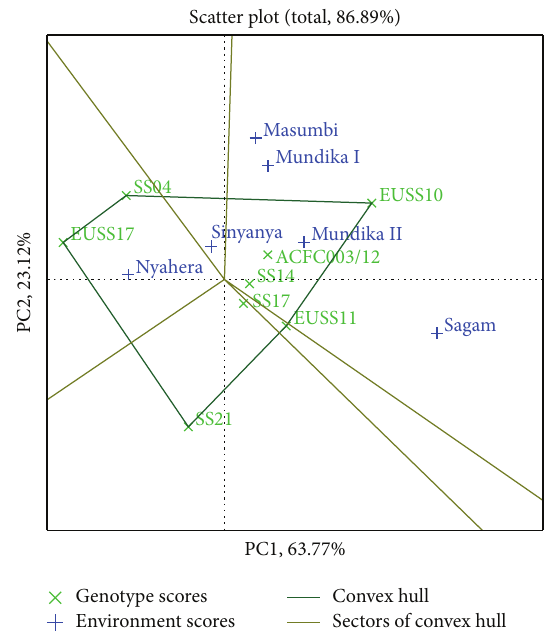
Figure 3: The which-won-where view of GGE biplot for cane yield.